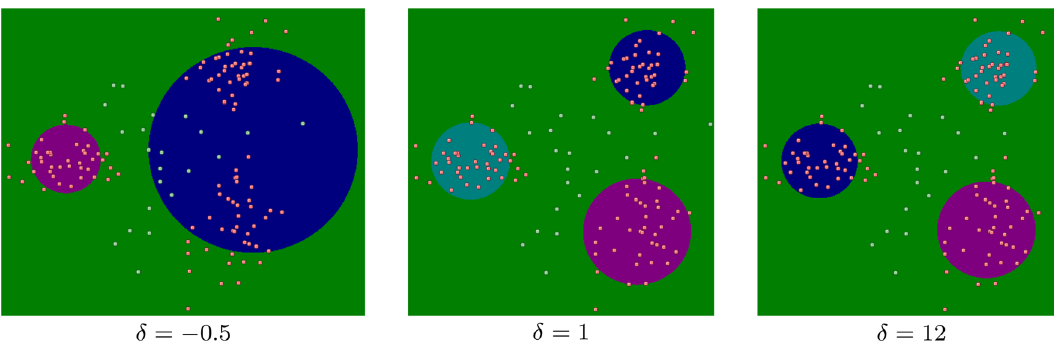
Fig. 7 Behavior of mSVDD when parameter δ is varied